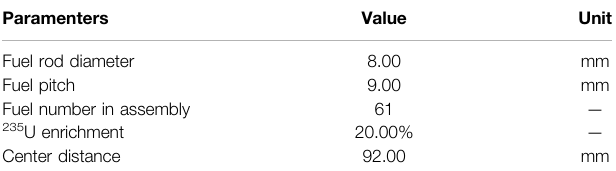
TABLE 1 | Fuel assembly design parameters. Paramenters